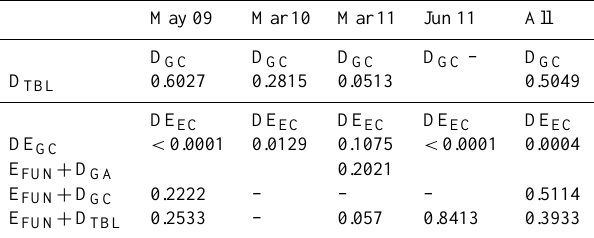
Table 2. Statistical test for the comparison of different methods to assess CH 4 emissions. The difference is significant if p <